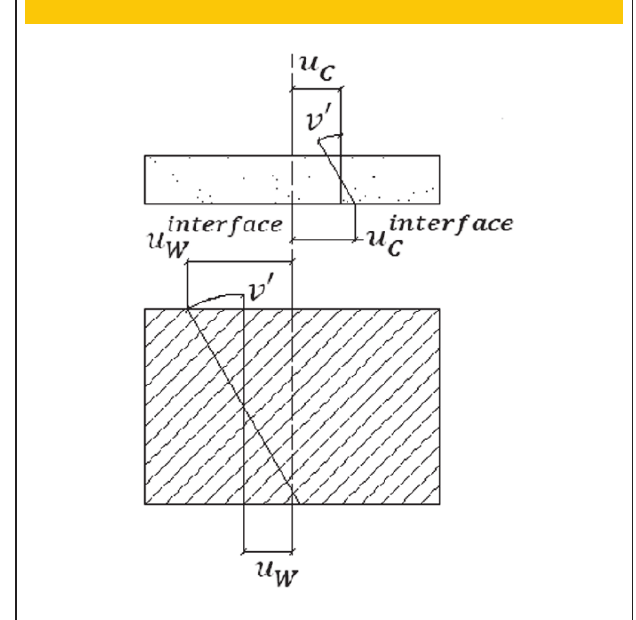
Figure 2 – Cross section of a T-shaped Figure 3 – Kinematics of a composite